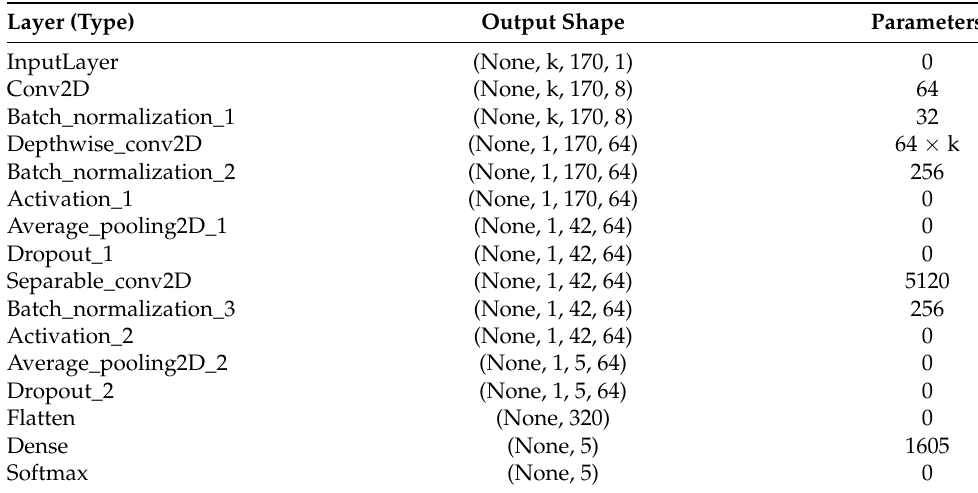
Table 2. Number of parameters for the implemented EEGNet receiving k channels.